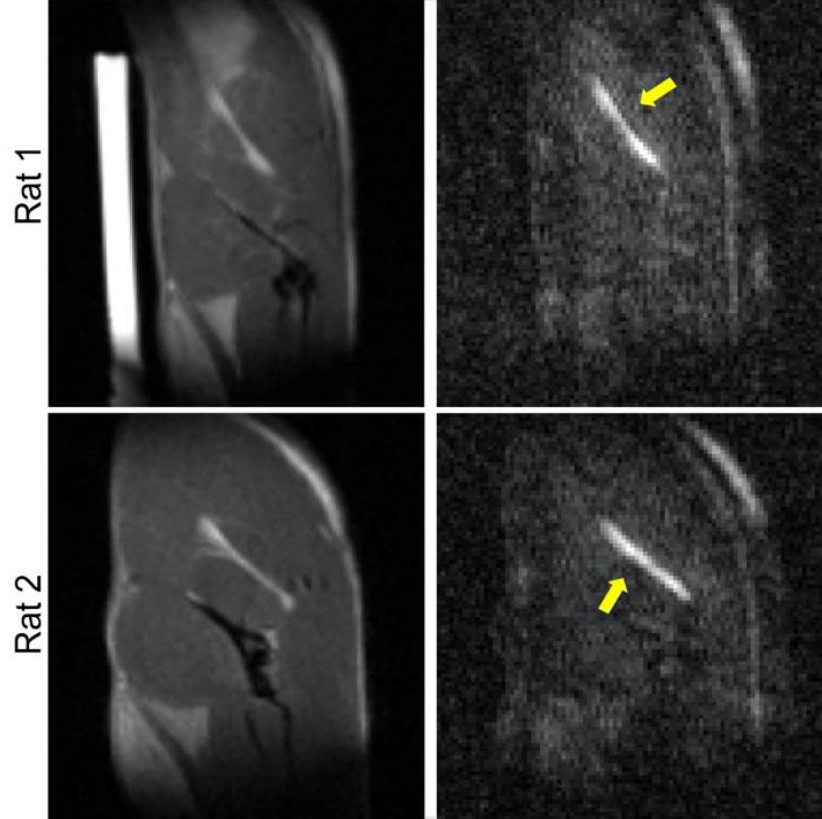
Figure 1. MRI of the rat sciatic nerve. Results are presented for 2 animals, with RARE and diffusion- weighted scans shown in the left and right columns, respectively. The latter are used to identify and confirm the locations of the nerve (arrows). The hyperintense cylindrical object in the top left image is a water-filled phantom used for reference purposes.